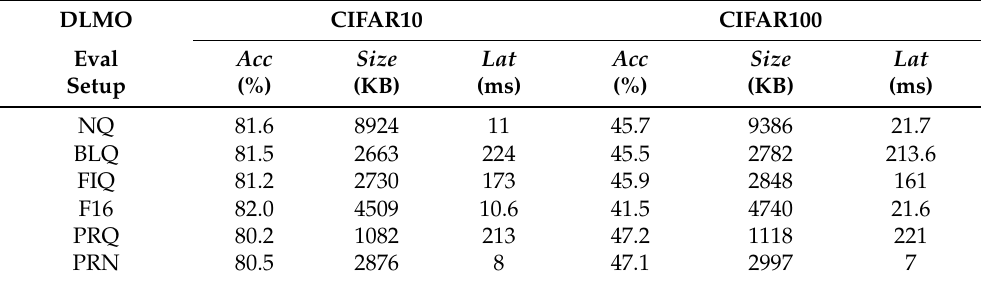
Table 9. MobileNet